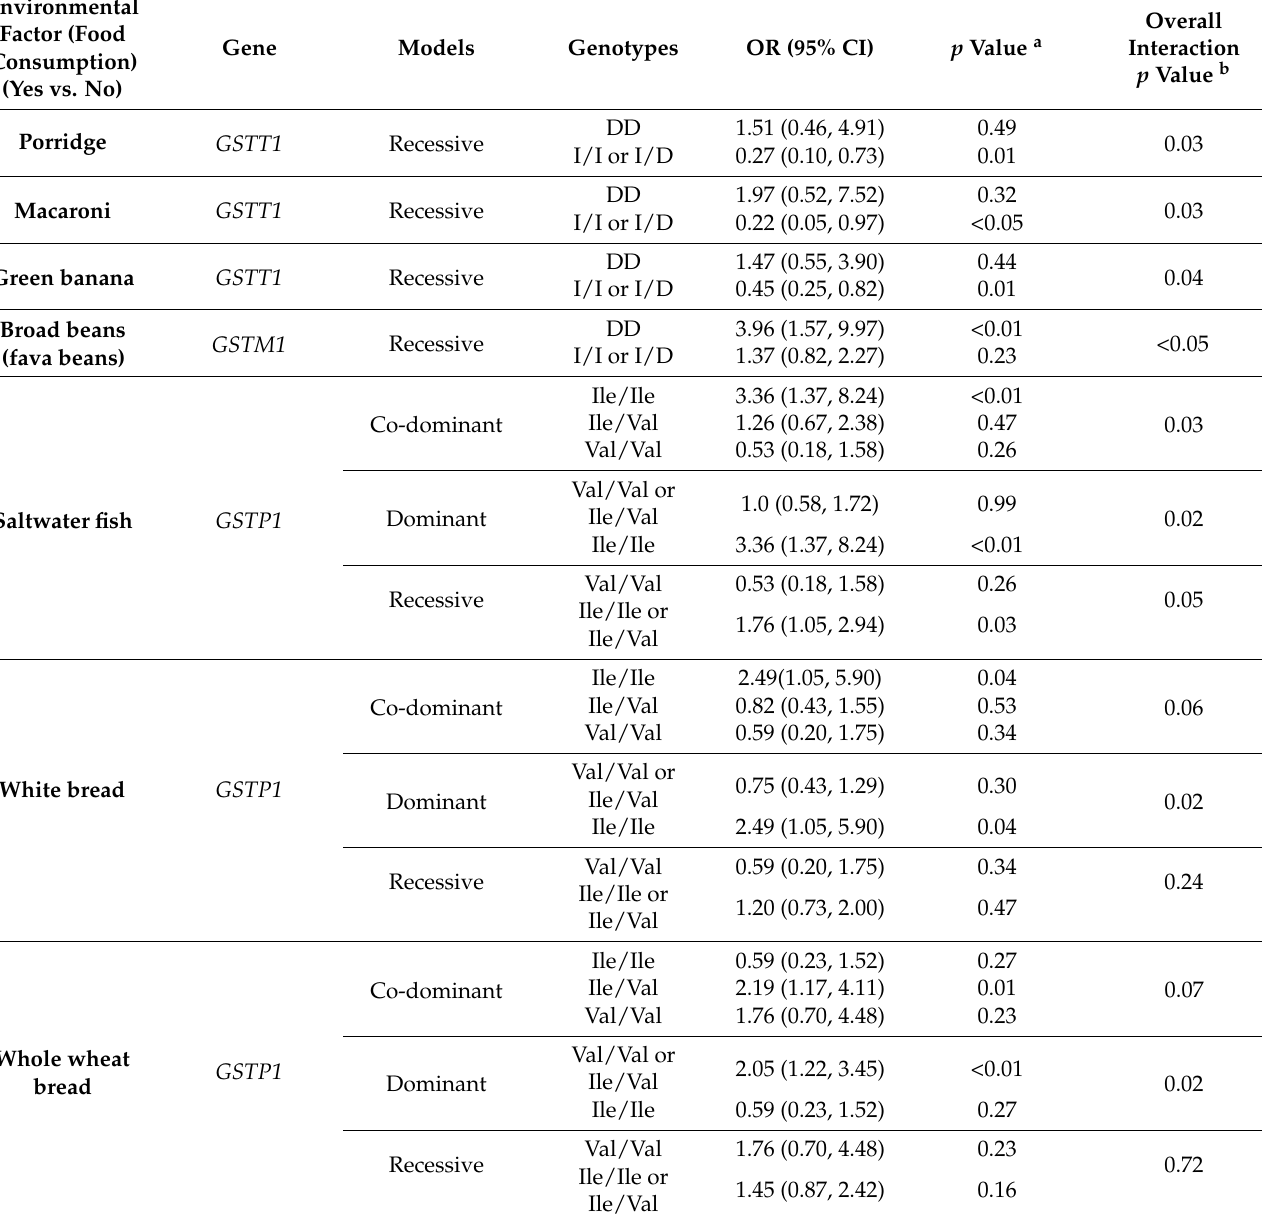
Table 4. Multivariable logistic regression analysis of associations between children’s exposure to environmental factors and binary detectable blood Al concentrations (BAlCs) by genotypes for GST genes that include gene*environment interaction (N =